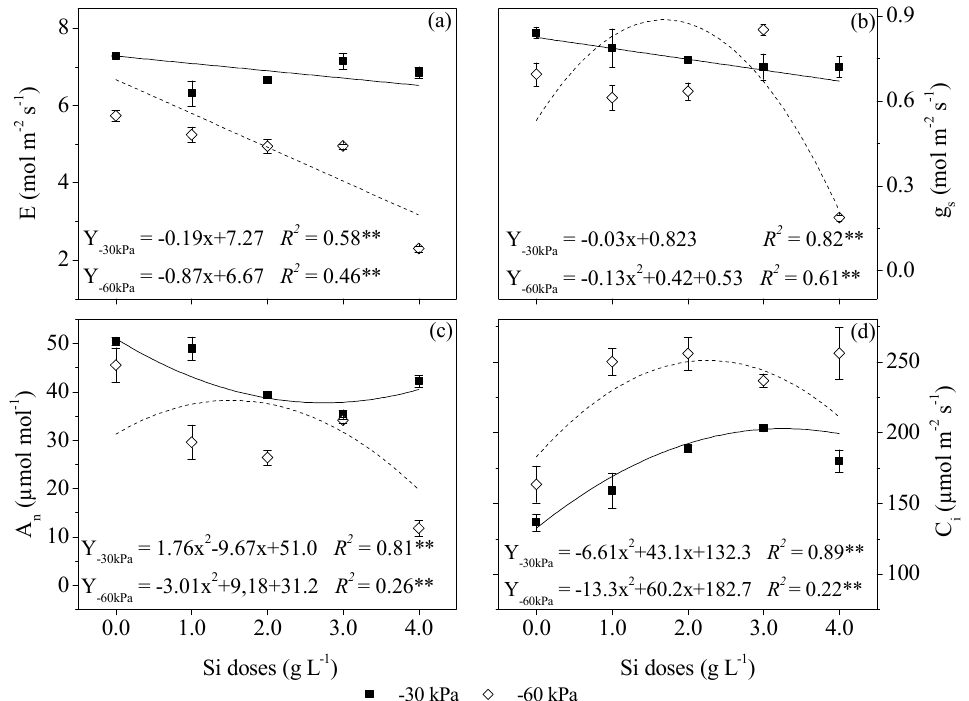
Figure 4. Responses of the transpiration rate ( a ), stomatal conductance ( b ), net photosynthesis assimilation rate ( c ), and internal concentration of CO 2 ( d ) to the different doses of Si (g L − 1 ) subjected to two levels of water restriction ( − 30 and − 60 kPa) at 34 DAT. (**) significant at 1% by F test. Agronomy 2020 , 10 , x FOR PEER REVIEW E and gs were reduced with the increase in Si at a soil water potential of − 30 kPa, at 34 DAT, where reductions, respectively, of 5.9% and 14.3% were observed between the control and maximum Si amount. The gs obtained a reduction of 73.1% when comparing the control to the maximum Si amount at a soil water potential of − 60 kPa (Figure 4). Tomato showed higher rates of gs (0.86 mol m − 2 s − 1 ), A n (38.20 μ mol mol − 1 ), and Ci (250.82 μ mol m − 2 s − 2 ) with foliar applications of 1.61, 1.52, and 2.26 g L − 1 of Si, respectively (Figure 4). The internal CO 2 concentration subjected to a lower water restriction ( Ψ s = − 30) also increased to 202.55 μ mol m − 2 s − 2 with the application of the estimated dose of 3.26 g L − 1 of Si (Figure 4).